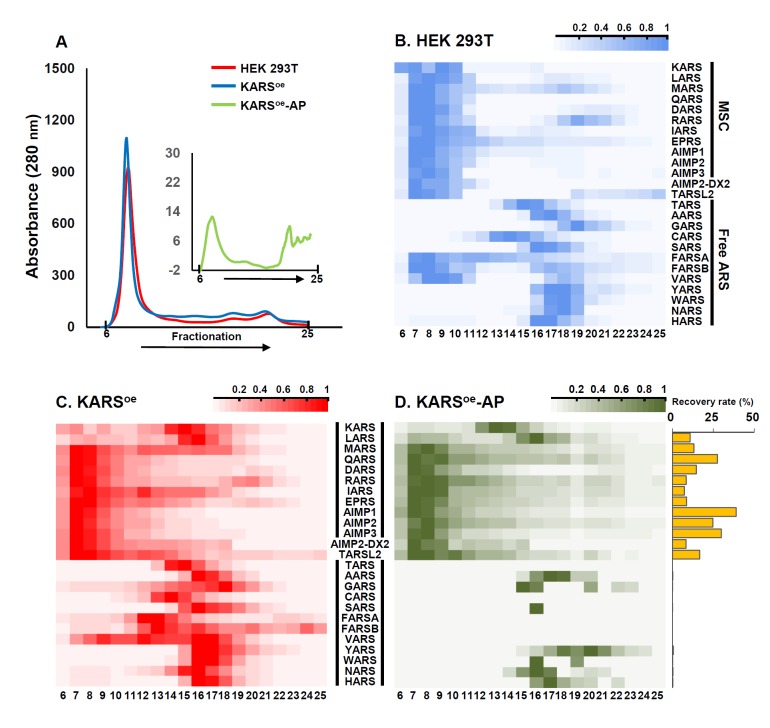
Two-dimensional MRM profile of ARS proteins in the fractions of size exclusion chromatography.
(A) Two cell lysates and affinity purification eluate were injected on a Superdex 200 column and the elution profile was recorded by following the 280 nm absorbance. Red: HEK 293T cell lysate; Blue: KARSoe cell lysate; Green; KARSoe-AP eluate. (B, C and D) The average amount of 25 ARS proteins in 20 fractions of HEK 293T (B), KARSoe (C) and KARSoe-AP (D) from duplicated LC-MRM runs is represented as heat maps. The average value is normalized against the largest value among the 20 fractions (S2, S3 and S4 Tables). In the heat maps, each row represents an ARS protein; each column represents an SEC fraction. (D, right panel) The histogram represents recovery rate (%) of each ARS protein after affinity purification. The recovery rate is a relative value to that of KARS which was used as a bait.